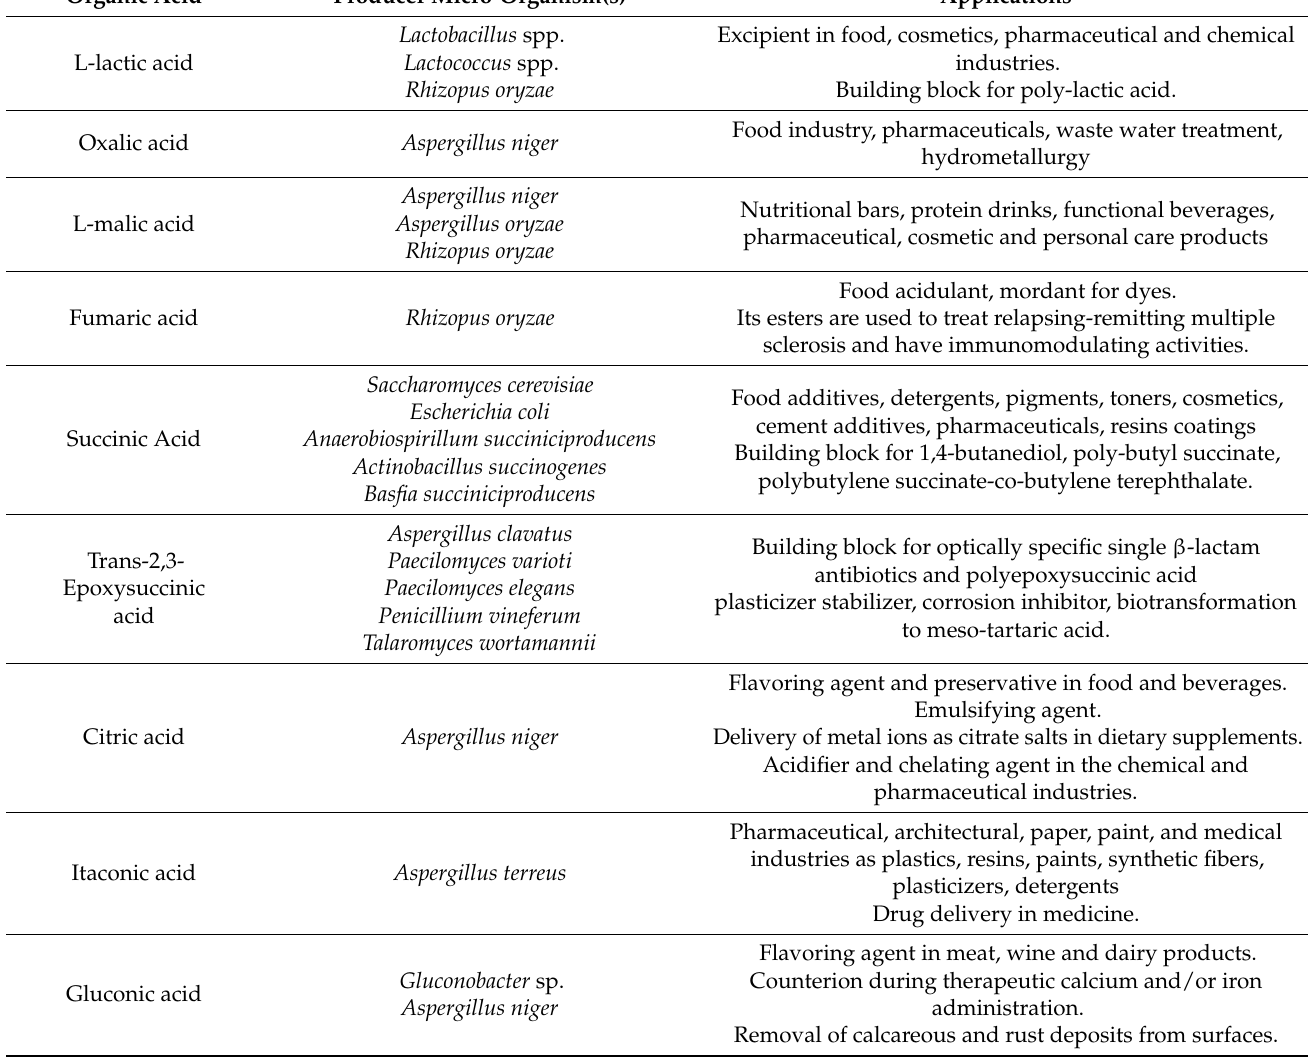
Table 1. Microbial producers and applications of organic acids produced partially or completely by biological means *. Organic